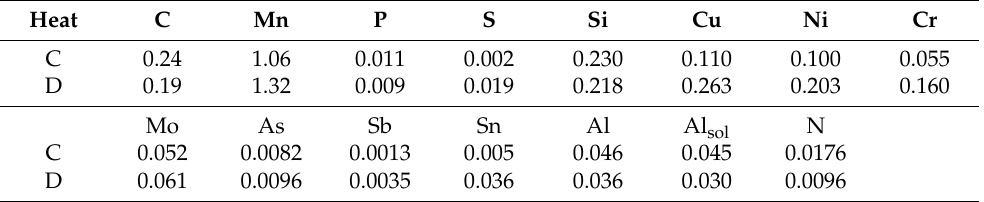
Table 1. Chemical composition of C-Mn steel heats C and D (wt%). Adapted from ref. [16].